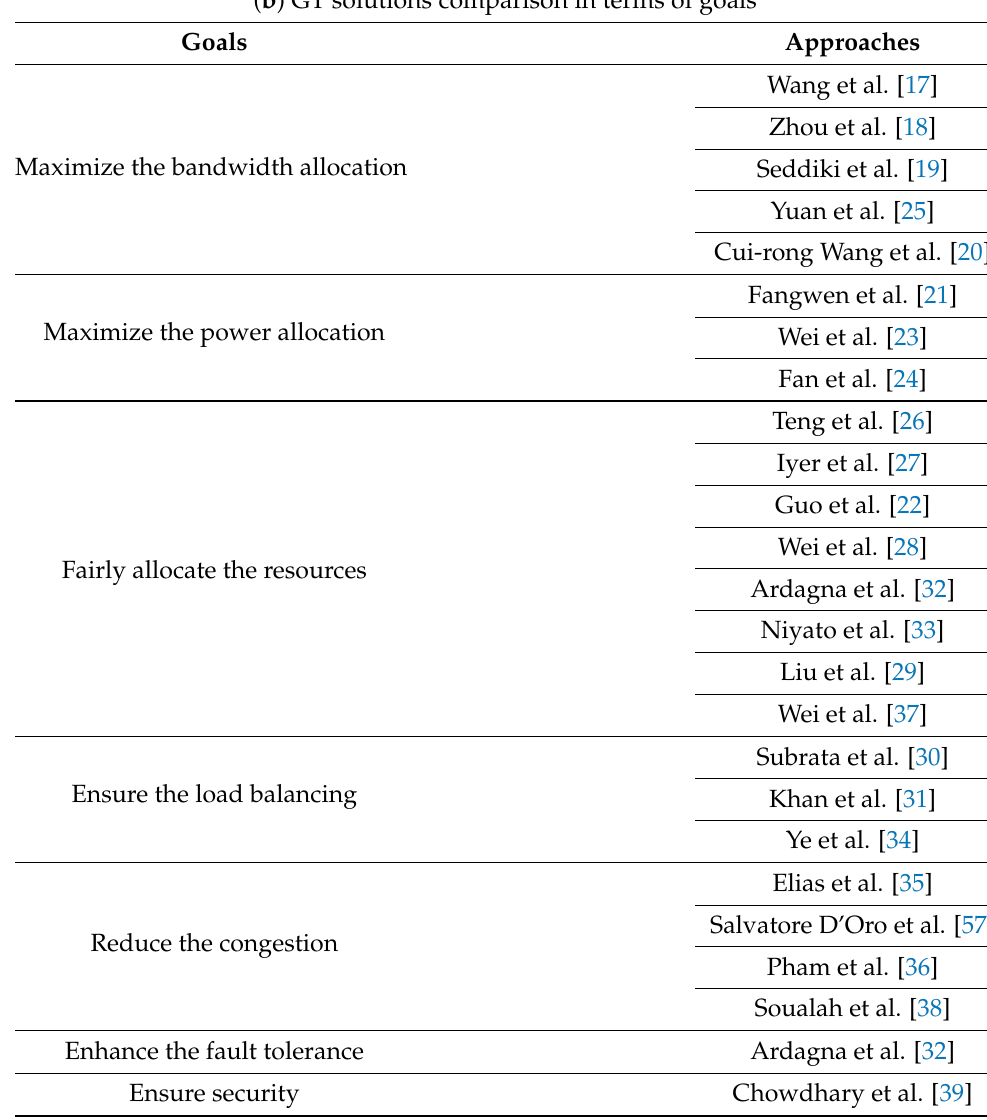
( b ) GT solutions comparison in terms of goals